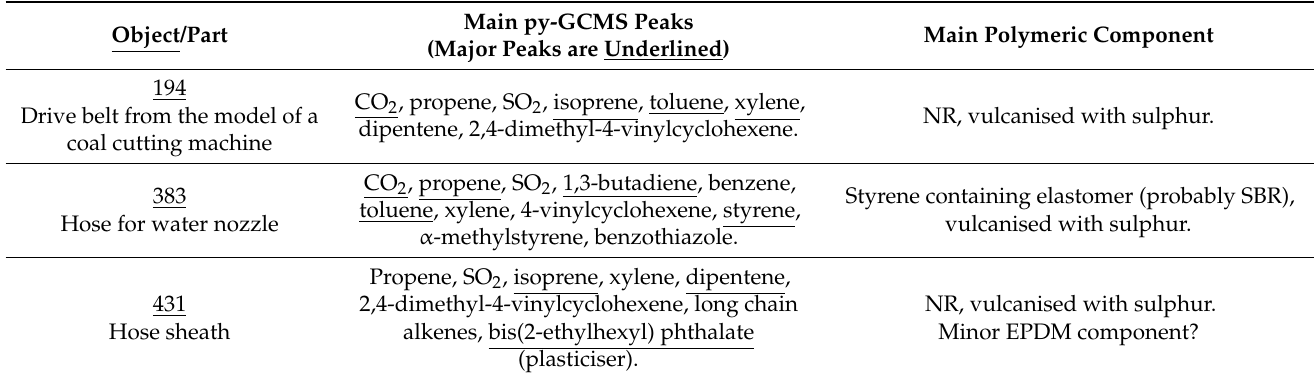
Table 10. Summary of the py ‐ GCMS results.